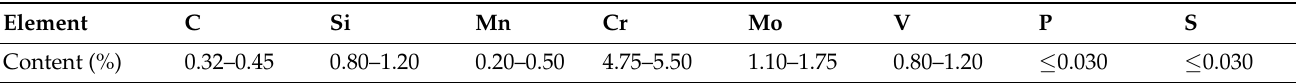
Table 1. Composition of H13 mold